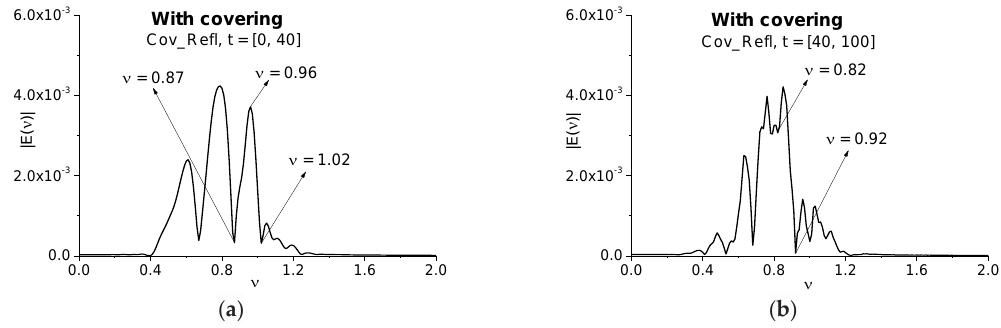
Figure 13. Fourier spectra of the signal reflected from the covered medium (Cov_Refl) and calculated in the time intervals t = [0, 40] ( a ) and t = [40, 100] ( b ). The corresponding evolution of the ICC’s CW e,E (a) and C e,E (b) are shown in Figure 14. The ICC C e,E is shown in the enlarged scale in order to demonstrate the difference between the lines for the frequency pairs ν = (0.92, 0.96) and ν = (0.96, 0.96), which are close to each other. One can see that the frequency ν = 0.92 is detected for both criteria in the FDR ν = [0.85, 0.96]. Therefore, the absorption frequency of the medium is found in the travelling part ( t > 40) of the signal Cov_Refl reflected from the covered medium, which does not contain the main pulse.